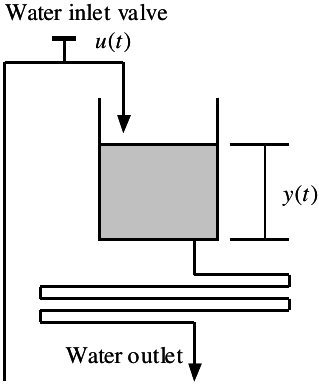
Figure 3. A water tank plant.